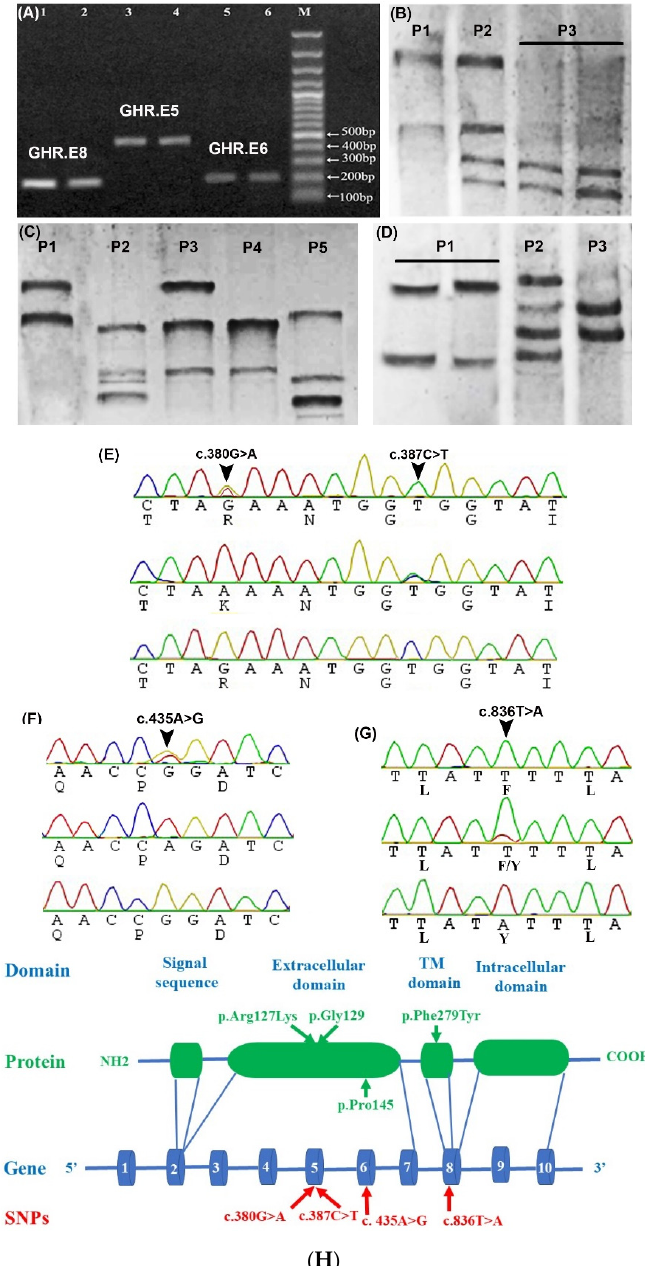
Figure 1. Detection of GHR SNPs using PCR- single strand conformation polymorphism (SSCP) and sequencing. ( A ) Agarose gel shows amplified fragments of GHR.E6 (205 bp, lanes 5 and 6), GHR.E5 (472 bp, lanes 3 and 4), and GHR.E8 (166 bp, lanes 1 and 2) from two different samples, M: 100 bp DNA ladder. ( B ) PCR-SSCP bands of GHR.E6 show three different patterns (P1-P3) in four different samples. ( C ) PCR-SSCP bands of GHR.E5 show five different patterns (P1-P5) in five different samples. ( D ) PCR-SSCP bands of GHR.E8 show three different patterns (P1-P3) in four different samples. ( E ) Sequences chromatogram spanning the site of c.380G>A (p.Arg(R)127Lys (K)) and c.387C>T (p.Gly(G)129) in E5. ( F ) Sequences chromatogram spanning the site of c.435A>G (p.Pro(P)145) in E6. ( G ) Sequences chromatogram spanning the site of c.836T>A (p.Phe(F)279Tyr(Y)) in E8. ( H ) Location of the predicted c.380G>A (p.Arg127Lys), c.387C>T (p.Gly129), c.435A>G (p.Pro145), and c.836T>A (p.Phe279Tyr) SNPs in the extracellular and transmembrane domains of the GHR protein. Blue cylinders indicate the exons (1–10).